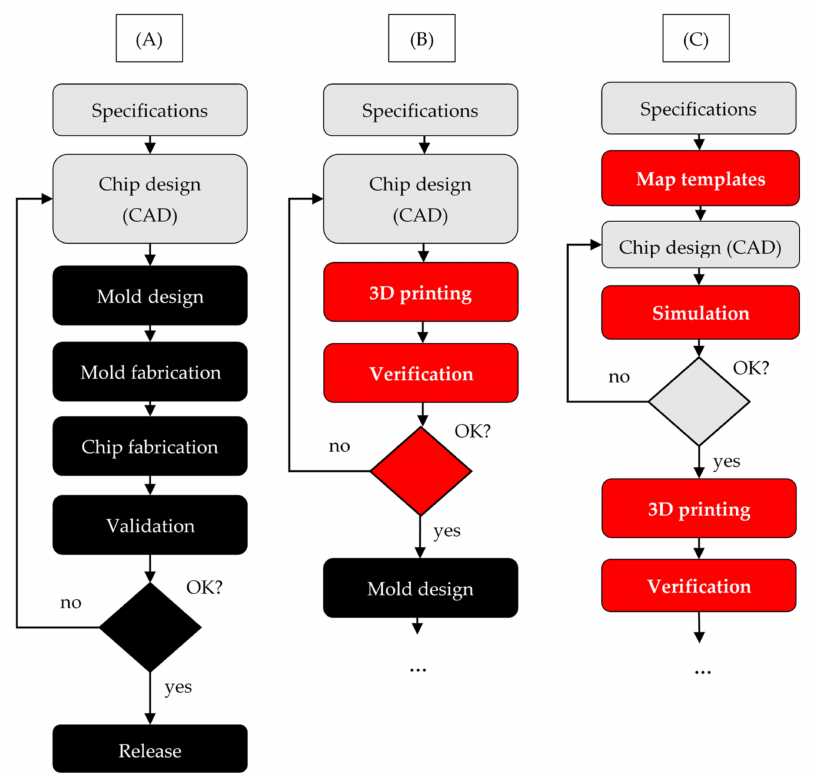
Figure 8. Combining cloud-based and online design sharing, digital twins and 3D printing could greatly decrease microfluidic chip fabrication costs and time. The microfluidic chip design (gray) and production (black) workflows are illustrated. Process steps related to digital twins, online design sharing and 3D printing are marked in red. In a traditional workflow ( A ), chip design is immediately followed by mold and chip fabrication, be it for PDMS or injection molding. If the design validation fails, a redesign incurs significant costs. In an alternative workflow ( B ), 3D printing is used to pre-test chip designs, and only after this test is successful is the mold designed and fabricated. However, to realize the full potential of 3D printing ( C ), digital twins should be used in conjunction with 3DP designs to speed up the process and save even more on fabrication costs and time. Furthermore, by using design templates from online repositories, the chip design process can be sped up and simplified. After this, the workflow can continue with mold design and fabrication. In the future, the end-user device could also be 3DP, depending on the use